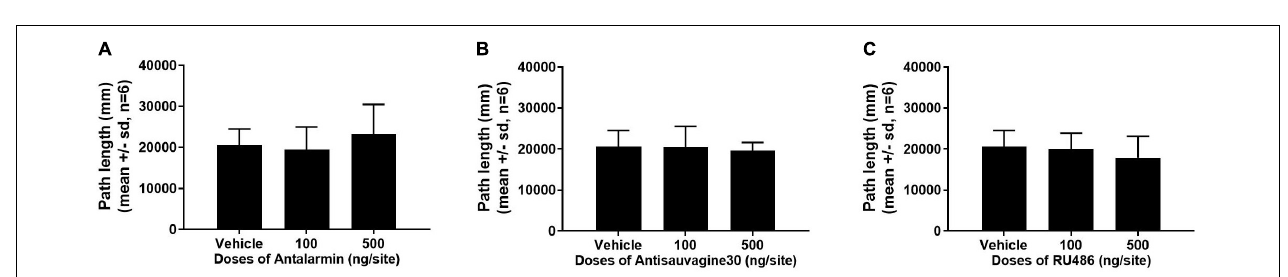
FIGURE 5 | The intra-lateral ventricle injection of antalarmin (A) , antisauvagine 30 (B) , or RU486 (C) bilaterally were unlikely to affect the numbers of active nose-poke responses, food tray, and inactive nose-poke responses in the rats who received tail clip stressful stimulation. The normally distributed data were analyzed with one-way ANOVA, otherwise was analyzed with a Kruskal–Wallis test. SD, standard deviation.